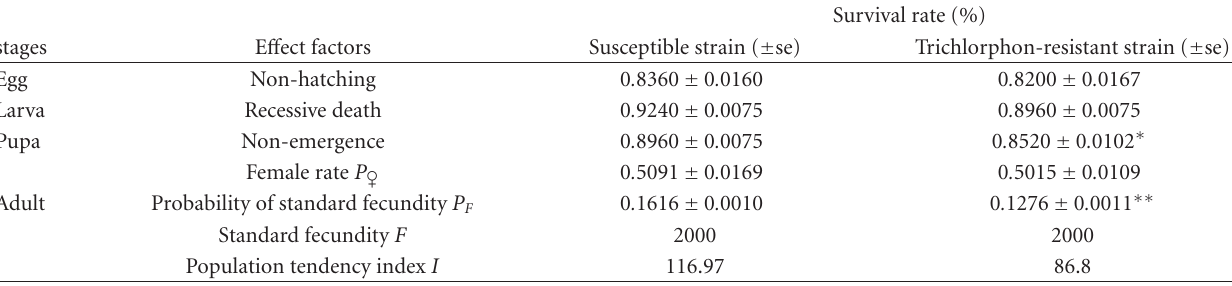
Table 3: The life table of lab population of two strains of B. dorsalis.